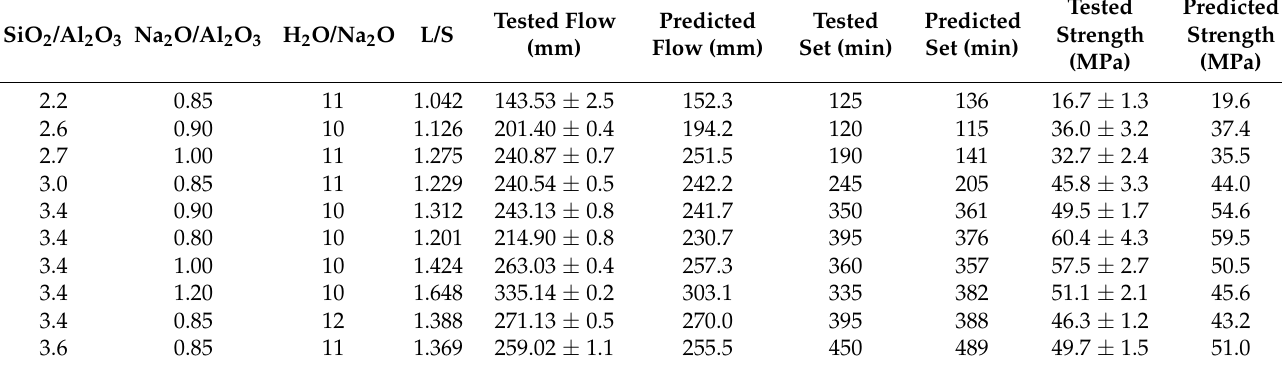
Table 6. Predicted outcomes for mixtures in the validating